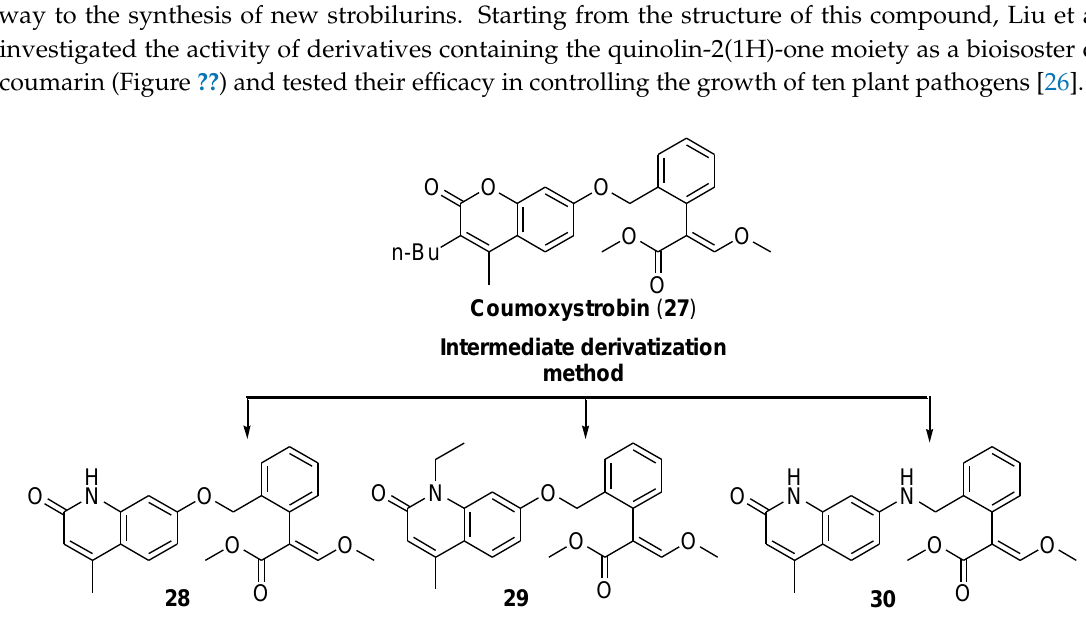
Figure 7. Structure of representative coumoxystrobin analogs 28 – 30 containing the quinolin-2(1H)-one